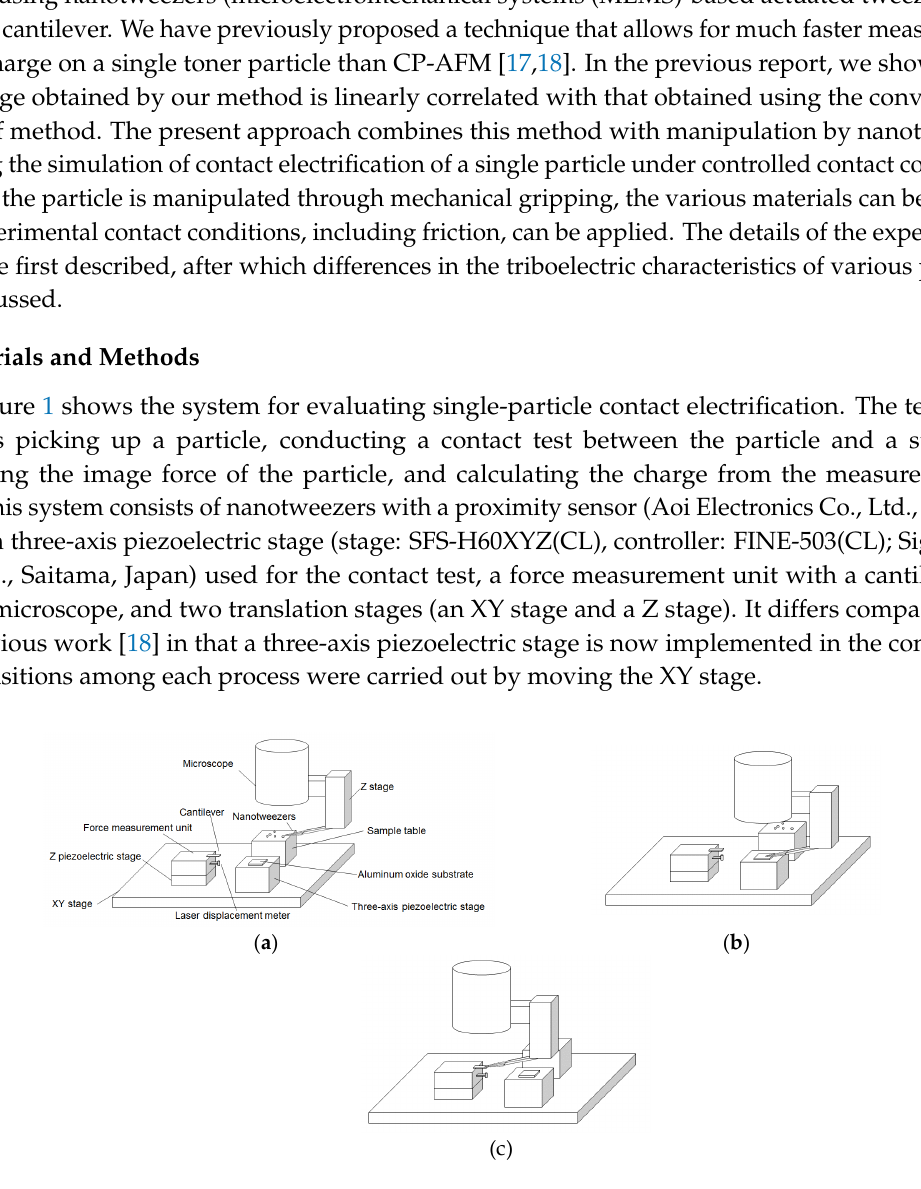
Figure 1. Experimental apparatus for evaluating the contact electrification of a single particle: ( a ) Picking up a toner particle; ( b ) Contact test; ( c ) Image force measurement.